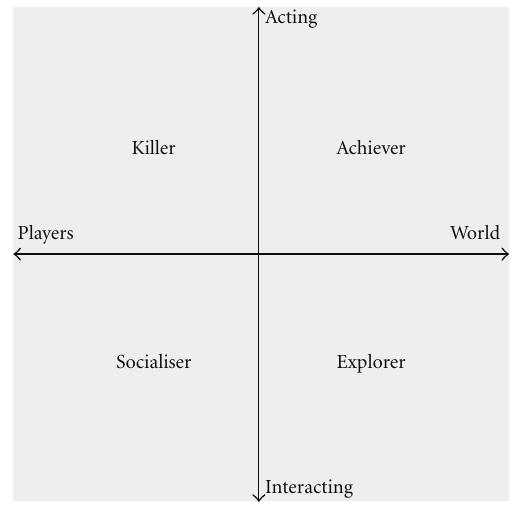
Figure 1: Bartle’s player